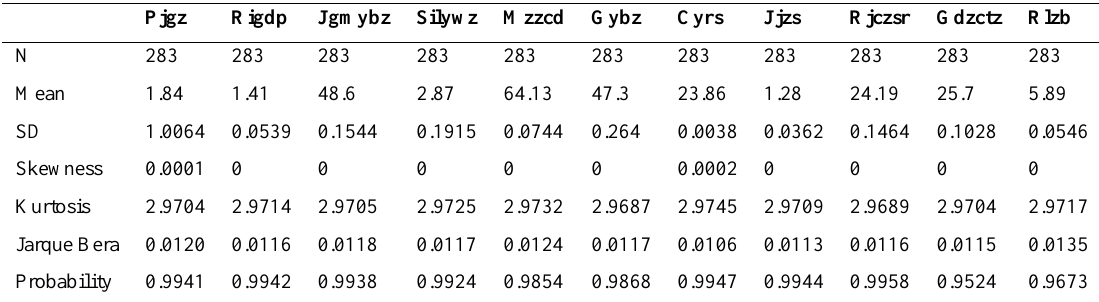
Fig. 2 Structure diagram of equation model Table 3 Test and analysis results of normalised